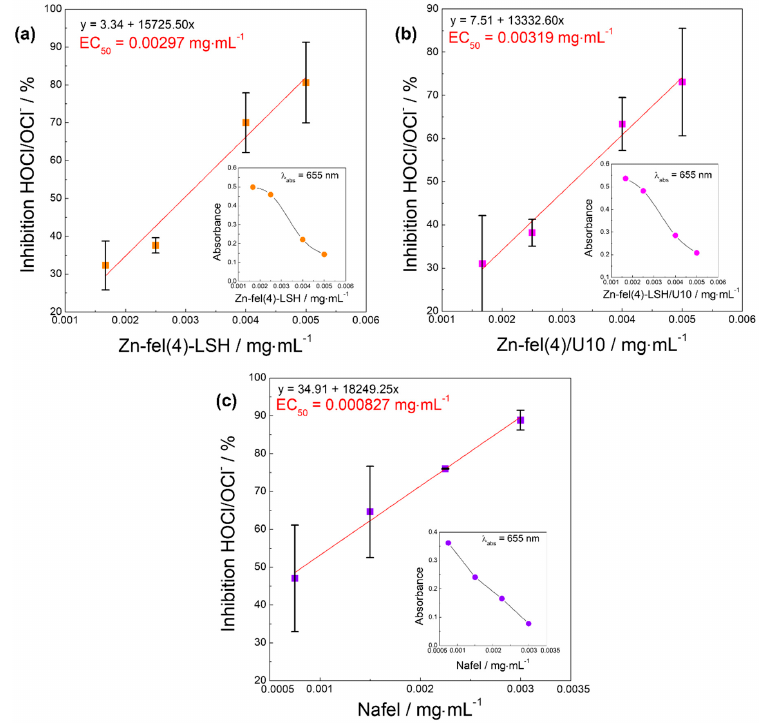
Figure 13. Inhibition (capture) of HOCl/OCl - reactive species by ( a ) Zn-fel(4)-LSH, ( b ) Zn-fel(4)-LSH/U10 and ( c ) Nafel (NaC 10 H 9 O 4 ) samples. Figures inserted show average absorbance of the TMB chromophore in presence of HOCl/OCl - species as function of sample concentration. The ROO • is a radical reactive species and is produced by the lipoperoxidation pro- cess (LPO) [63]. Among experimental methods used to investigate the inhibition of the LPO mechanism, Crocin bleaching assay is suitable to evaluate the antioxidant activity against ROO • radicals [57,63]. This assay is based on the bleaching rate of the crocin solu- tion in the presence of antioxidants; therefore, the ROO • capturing ability depends on ki- netic competition between crocin and antioxidant compounds. The ROO • scavenging ac- tivity is directly related to the angular coefficient obtained by linear regression from V 0 /V versus [Antioxidant]/[Crocin] graphs. Higher angular coefficient values indicate higher antioxidant activity of samples. The results of the Crocin bleaching assay (Figure 14 and Figure A8) show that samples exhibit ROO • scavenging activity; therefore, LSH-feru- late materials have potential to reduce the LPO of cellular membranes. According to slope and EC 50 values of samples (Table 5), the increasing order of the antioxidant ability is: Zn-fel(4)-LSH/U10 < Zn-fel(4)-LSH < Nafel.